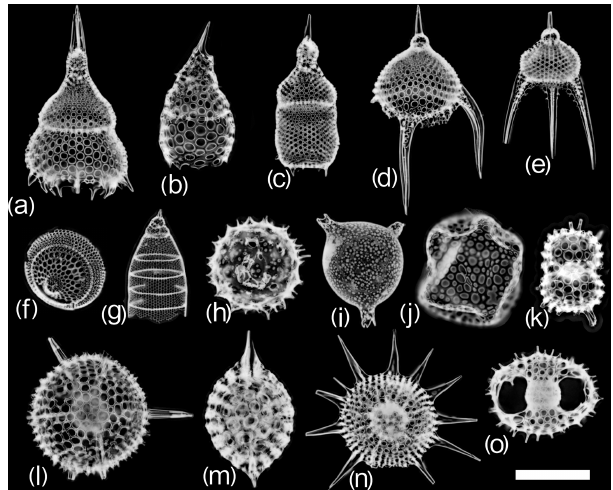
Figure 3. Examples of radiolarian vignettes generated by the automated acquisition, processing and recognition workflow for (a) Lamprocyclas maritalis , (b) Lamprocyrtis hannai , (c) Theo- corythium trachelium , (d) Pterocanium trilobum , (e) Pterocanium praetextum , (f) Eucecryphalus sestrodiscus , (g) Eucyrtidium acumi- natum/hexagonatum , (h) Acrosphaera spinosa , (i) Solenosphaera chierchiae , (j) Collosphaera tuberosa , (k) Didymocyrtis tetratha- lamus tetrathalamus , (l) Hexacontium spp., (m) Stylatractus nep- tunus , (n) Heliodiscus asteriscus and (o) the Tetrapyle octacantha group. The scale bar represents